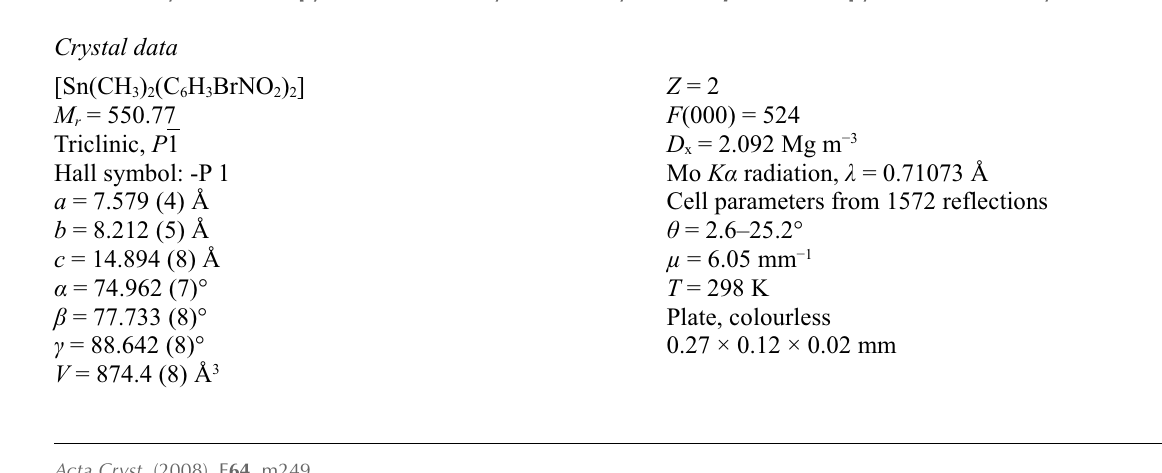
sup-2 Acta Cryst. (2008). E 64 , m249